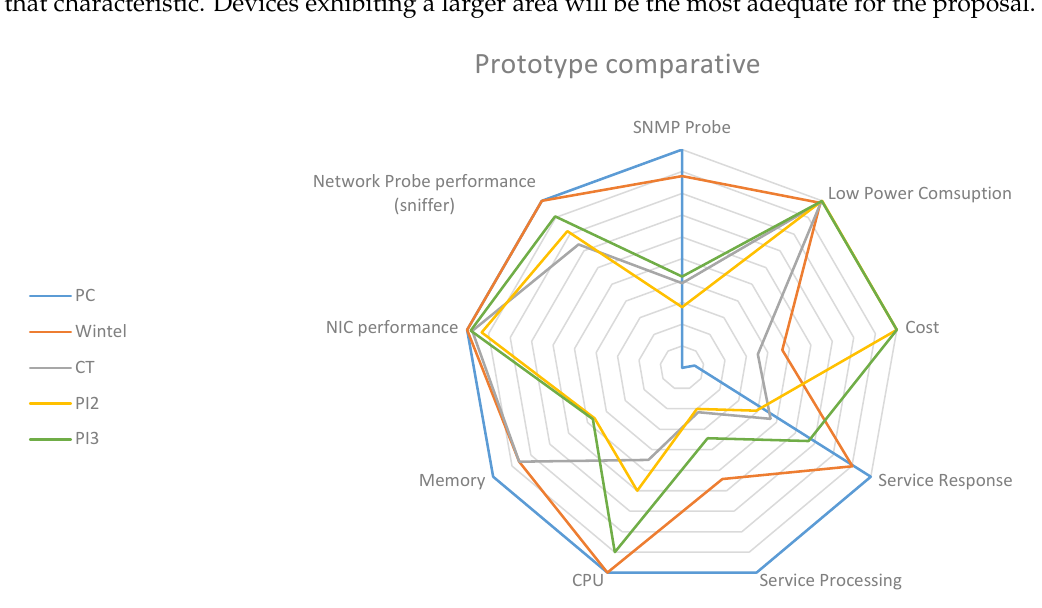
Figure 12. Comparative summary of the results obtained in the first